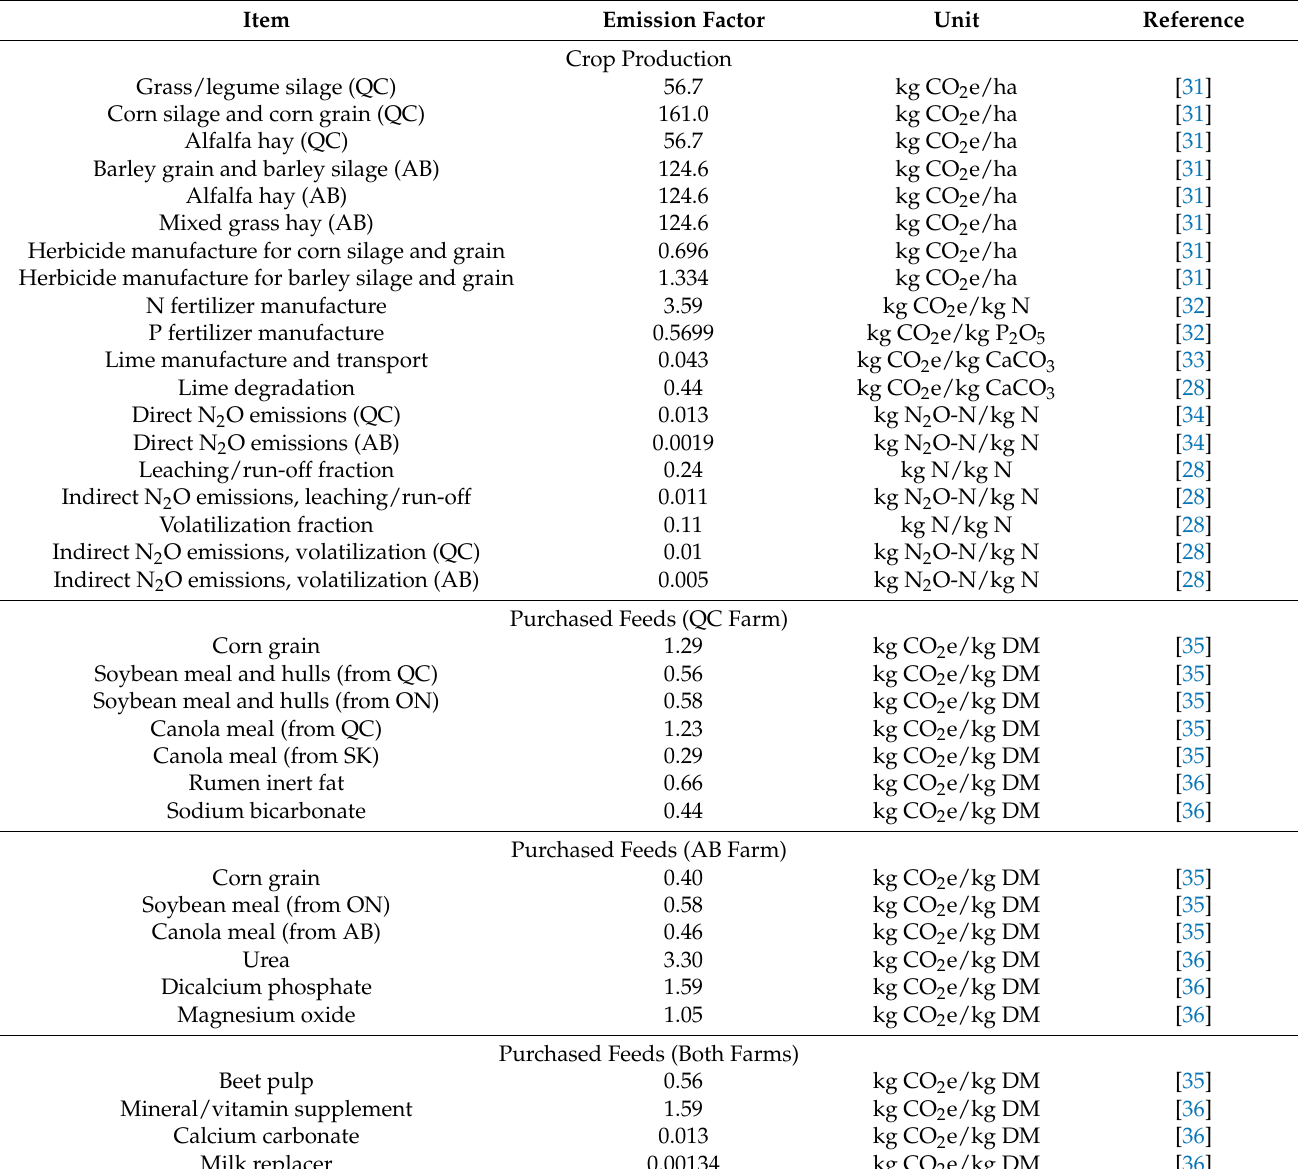
Table 4. Greenhouse gas emission factors associated with crop production and processing, as well as imported